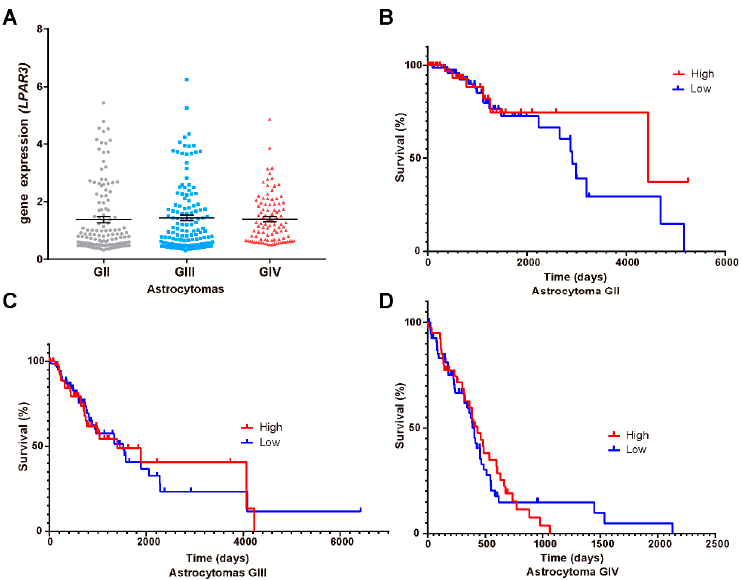
Figure 6. LPAR3 mRNA expression and astrocytoma patient’s survival. ( A ) LPAR3 mRNA expression (RNA-seq Illumina HiSeq, log2(norm count + 1)) in TCGA datasets ± SEM in different grades (G) of astrocytomas. The one-way ANOVA statistical test followed by a Tukey post-test determined the statistical difference. The Kaplan–Meier graphs show survival curves in patients that express low or high levels of LPAR3 in astrocytomas ( B ) GII, ( C ) GIII and ( D ) GIV(GBM). Statistical analysis between high and low expression of LPAR3 was performed with a Log-rank (Mantel–Cox) test. No statistical difference was observed.